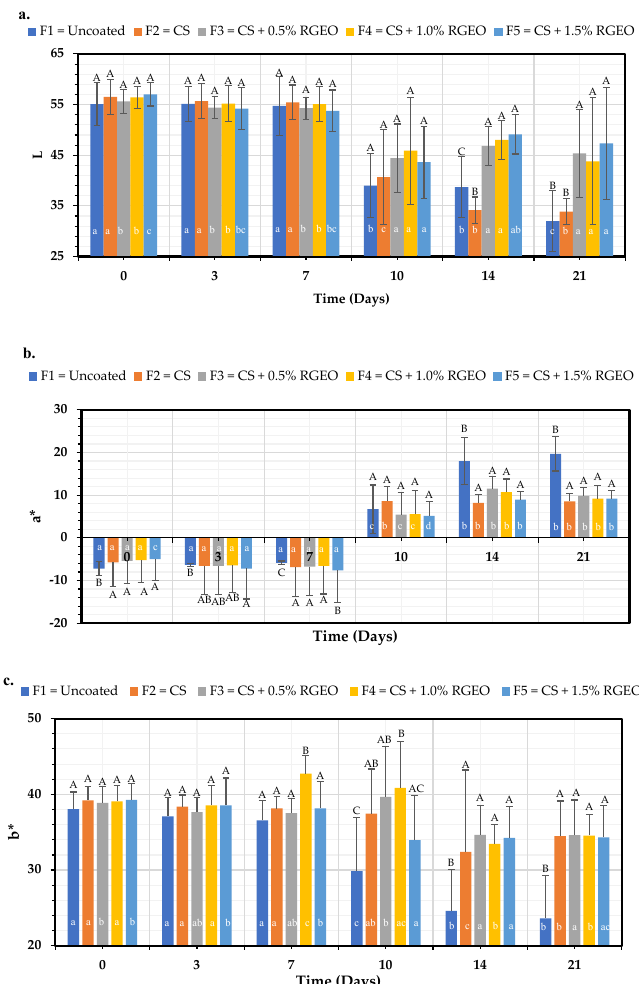
Figure 7. Color evolution where ( a ) L represented the lightness of the color, ( b ) a* its position between red and green and ( c ) b* its position between yellow and blue during 24 days of pears with CS + RGEO treatments: F1 = control, F2 = CS, F3 = CS + RGEO 0.5%, F4 = CS + RGEO 1.0%, and F5 = CS + RGEO 1.5%. According to the ANOVA test, mean values and intervals of Duncan test for treatments and Fisher for days with 95%. Different lowercase letters (a, b, c) indicate significant differences between days according to the LSD Fisher test for each treatment in a confidence interval of 95%. In contrast, different uppercase letters (A, B, C) indicate significant differences between treatments for each day according to the Duncan test in a confidence interval of